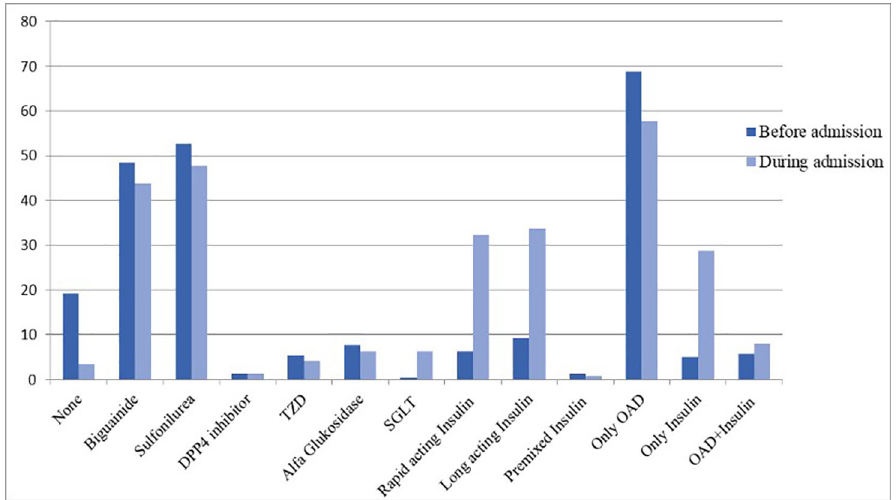
Figure 2. Diabetes mellitus therapies performed on the patients before and during hospital admission. DPP4 = dipeptidyl peptidase-4; OAD = oral antidiabetic drug; SGLT = sodium-glucose linked transporter; TZD = thiazolidinedione.